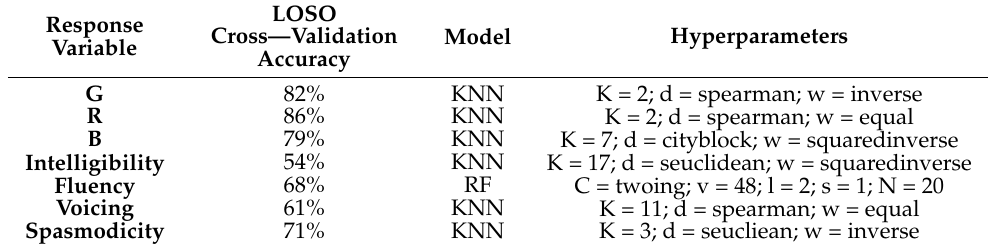
Table 4. Best classification results for the first AI experiment.